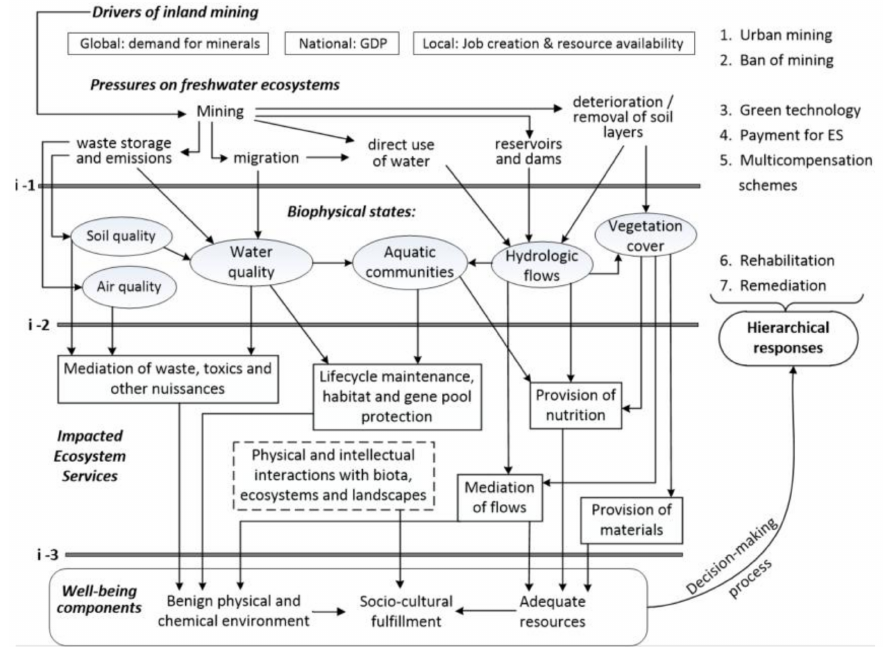
Figure 3. Summary of main conceptual elements used for assessing freshwater ES in mining contexts, structured in a driver-pressure-state-ES-response (DPSER) framework. Arrows represent cause–effect links, and the interfaces i-1 , i-2 and i-3 represent the ‘selection of data and models’ interface, the ‘ES production function assumption’ interface and the ‘response justification’ interface,